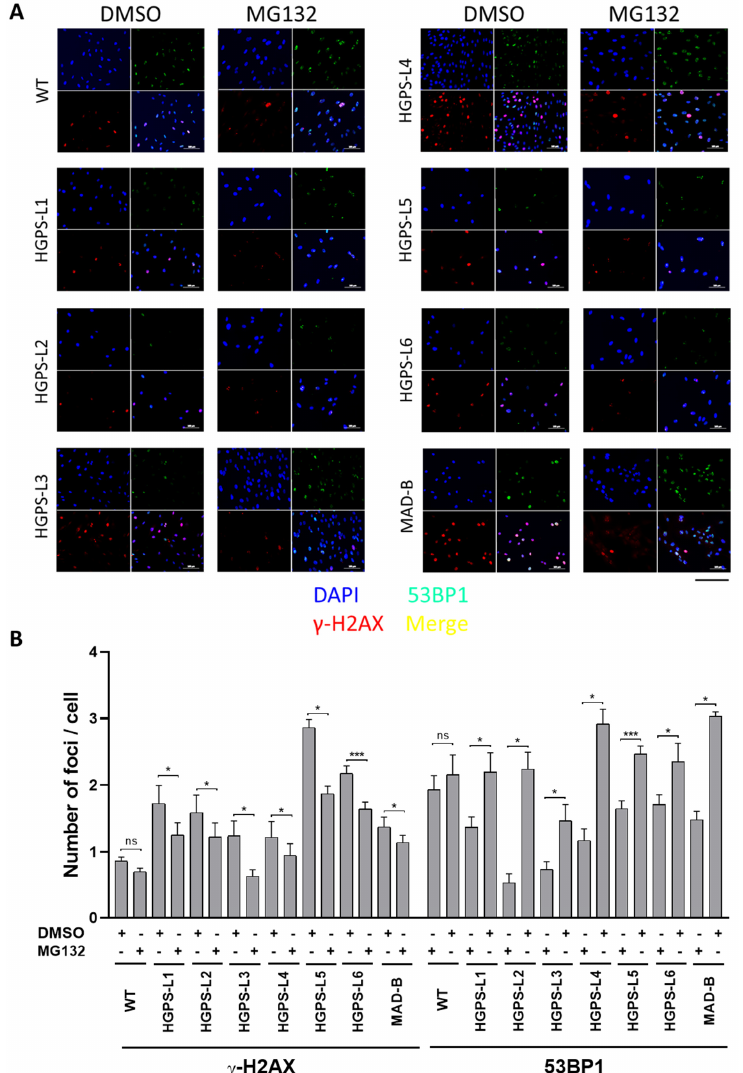
Figure 5. Treatment of HGPS-like and MAD-B cells with MG132 reduces the levels of DNA damage. ( A ) Immunofluorescence microscopy on primary dermal fibroblasts from a healthy individual (WT) and HGPS-like and MAD-B patients, treated with 500 nM MG132 or an equal volume of DMSO for 48 h. Cells were stained with DAPI (blue) and antibodies to the indicated proteins. Scale bar, 200 µ m. ( B ) Quantification of the number of foci of γ -H2AX and 53BP1 per cell in MG132-treated fibroblasts compared to DMSO-treated fibroblasts (mean ± SEM, n = 3, Student’s t -test, * p < 0.05, *** p <